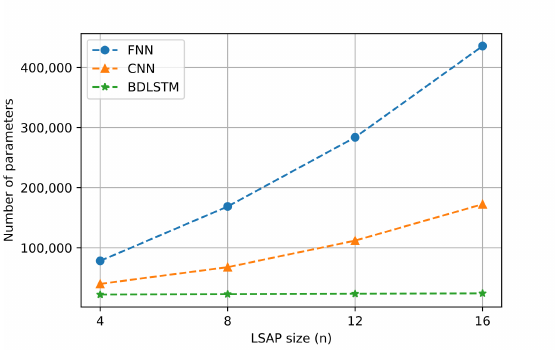
Figure 6. Complexity